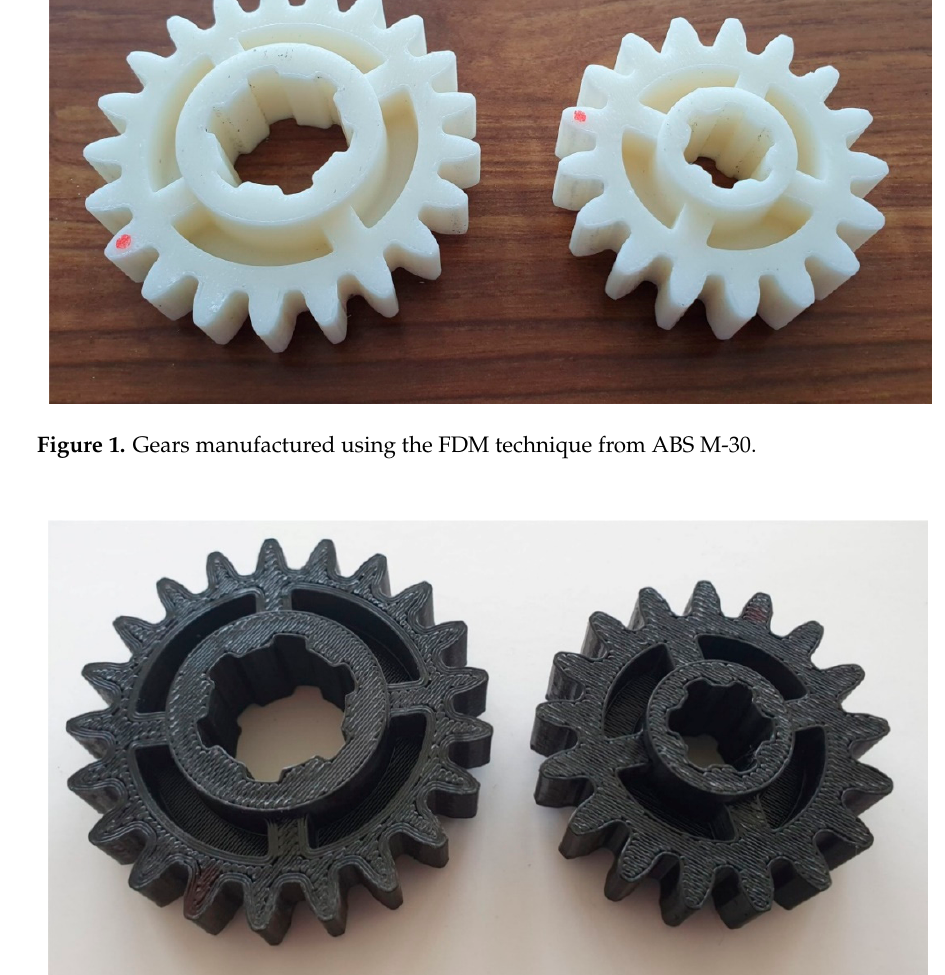
Figure 2. Gears manufactured using the FDM technique from ULTEM 9085.